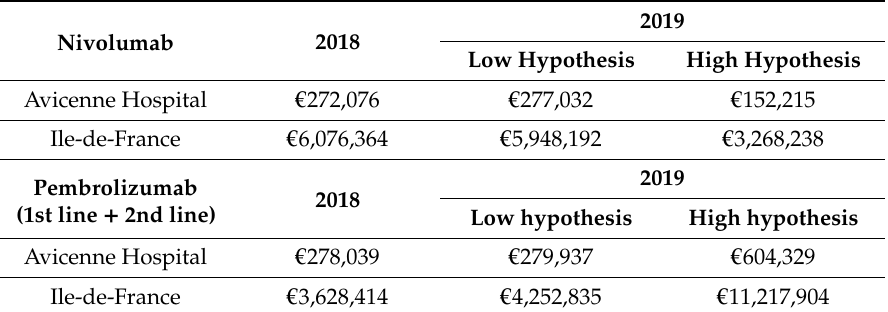
Table 6. Global annual additional cost per molecule for the analyzed population.